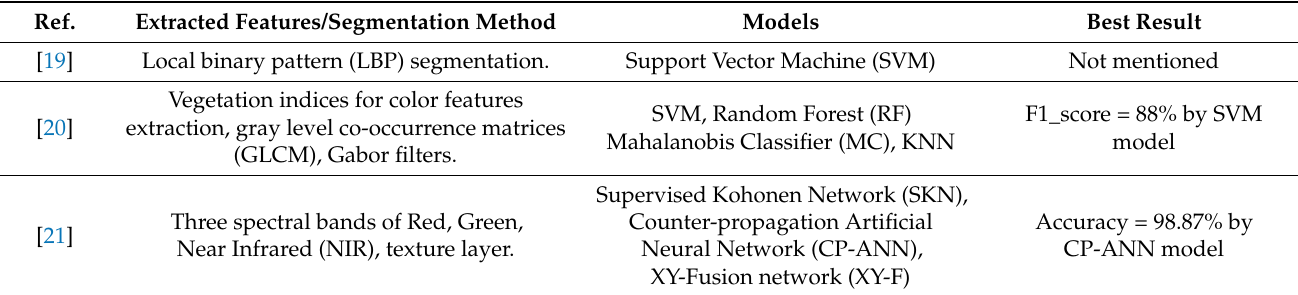
Table 2. Weed-detection-related work using ML techniques.